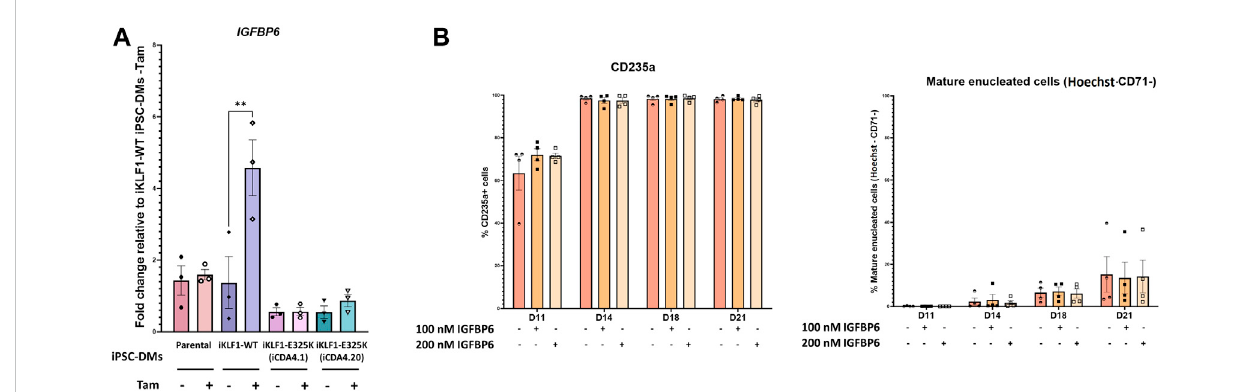
FIGURE 5 IGFBP6 alone has no effect on erythroid cell maturation and enucleation. (A) Gene expression of IGFBP6 assessed by qRT-PCR. Datapoints represent individual macrophage harvests. Error bars represent SEM. One-way ANOVA with Tukey post-test. ** p < 0.01. (B) IGFBP6 was added to UCB- derived CD34 + cells under erythroid differentiation conditions every 2 days at a concentration of either 100 nM or 200 nM. Quanti fi cation of fl ow cytometry analyses of suspension cells for CD235a, CD71 and Hoechst at days 11, 14, 18 and 21 of the culture. Datapoints represent individual experiments. Error bars represent SEM. One-way ANOVA with Tukey post-test generated no statistically signi fi cant